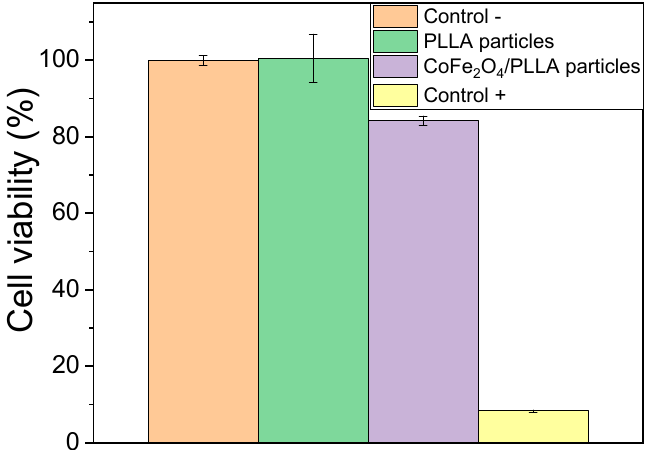
Figure 4. Cytotoxicity assay results of the 3T3 fibroblast cells in contact with the as-prepared extraction media exposed to the poly (L-lactic acid) (PLLA) and CoFe 2 O 4 / PLLA particles after 72 h (relative metabolic activity was presented as the percentage of the negative control with n = 4 ± standard deviation).